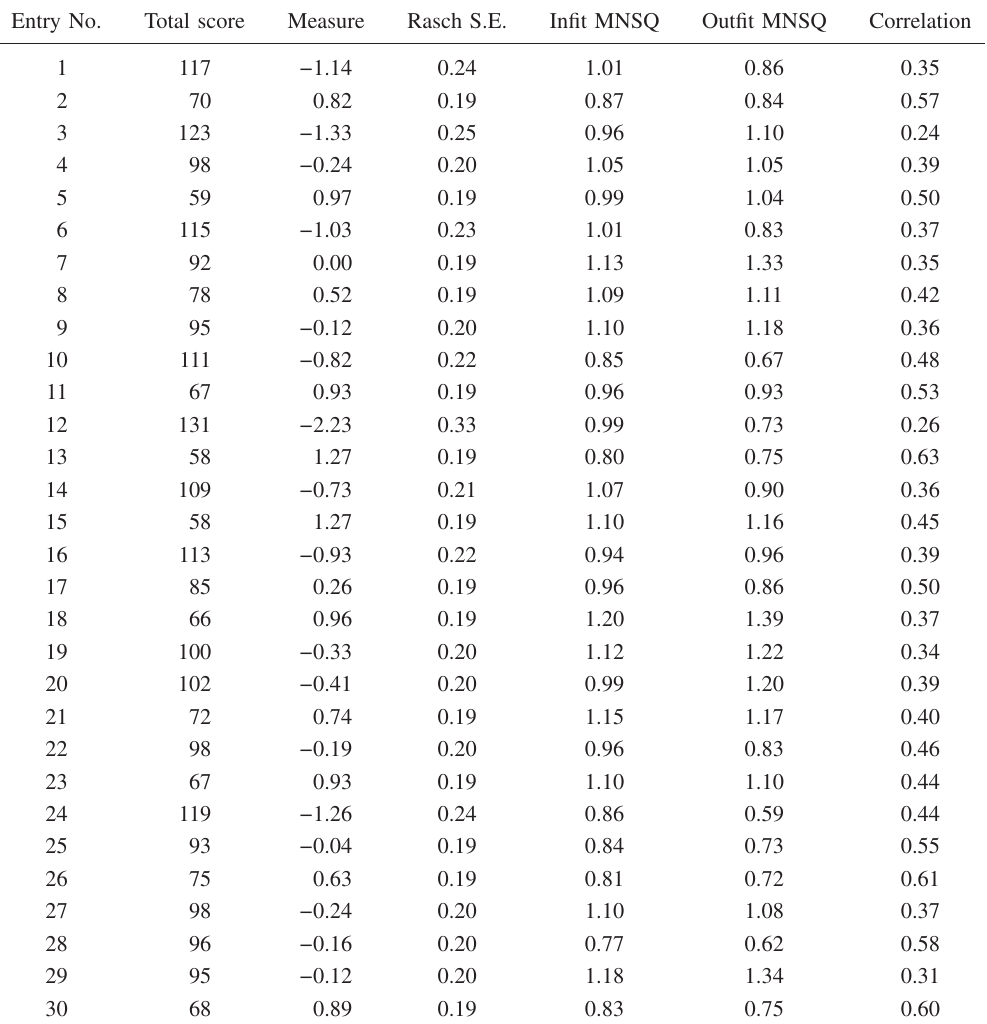
TABLE III. Statistical information for items for the Rasch analysis of the university sample. Displayed are total raw score, item measure in logit, Rasch standard error, infit and outfit MNSQ statistics, and point- measure correlation for each